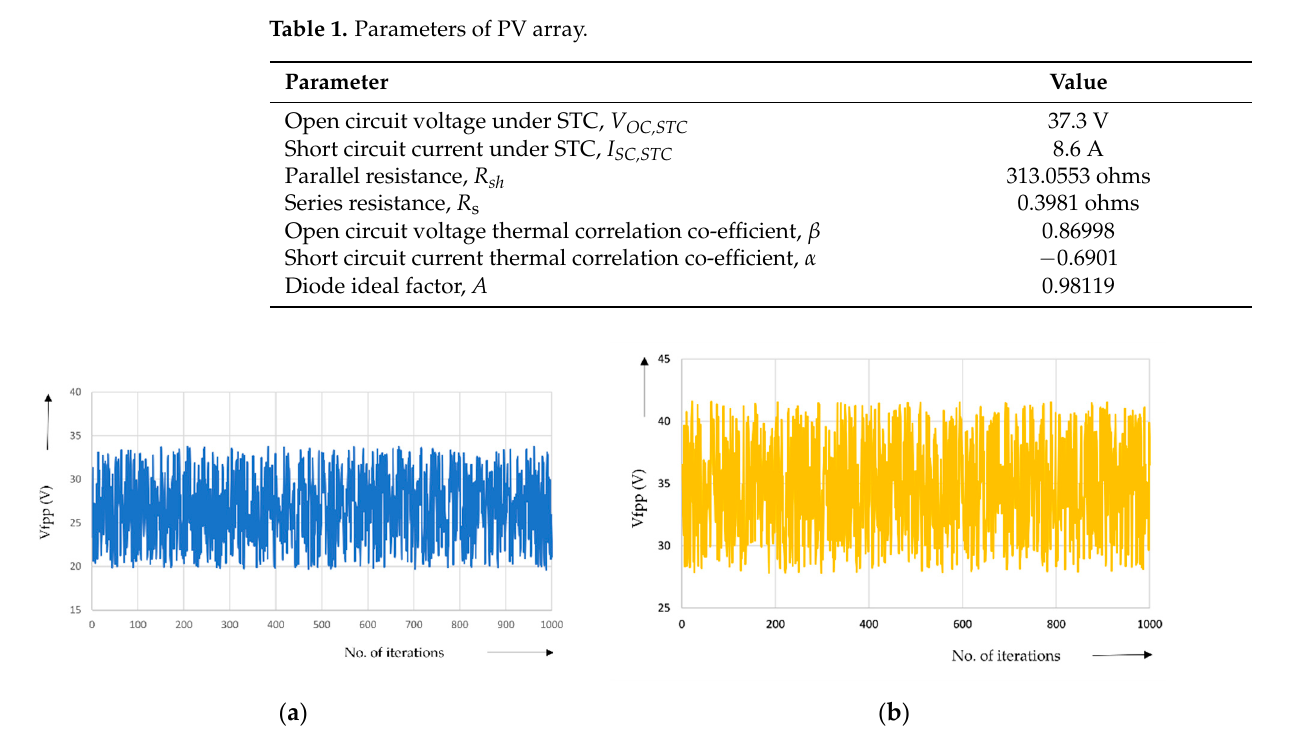
Figure 13. The trained PV output voltages for ( a ) left-hand-side operation and ( b ) right-hand-side operation. Table 2. Comparative study of the proposed control method with work from the existing